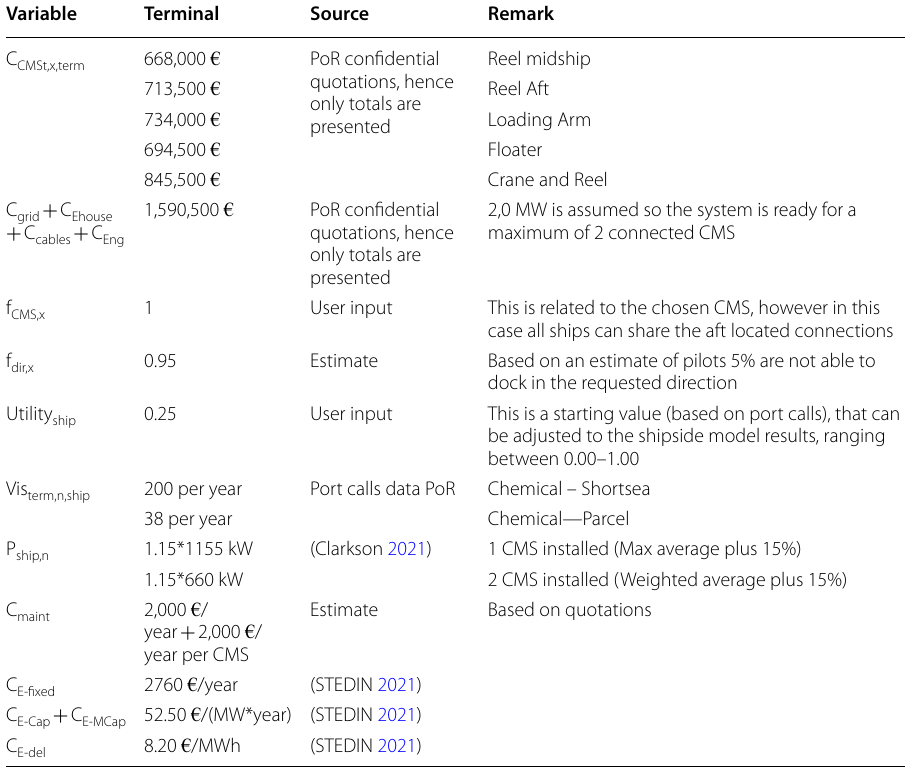
Table 4 Overview of terminal side related input for the model. Source : Authors Variable